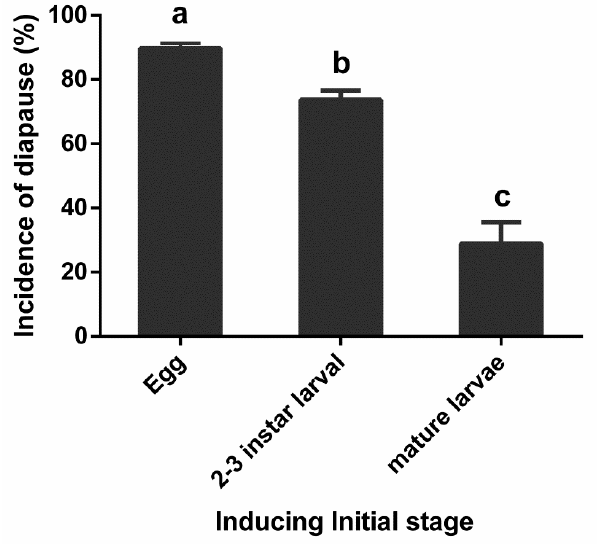
Figure 3. Effect of initial inducing stage on diapause induction of Anastatus japonicus at 17 °C under photoperiods of 6L:18D (mean ± SE%). Different letters indicate significant difference (one-way ANOVA, followed by LSD multiple-comparison tests, p < 0.05) between different initial inducing stages.